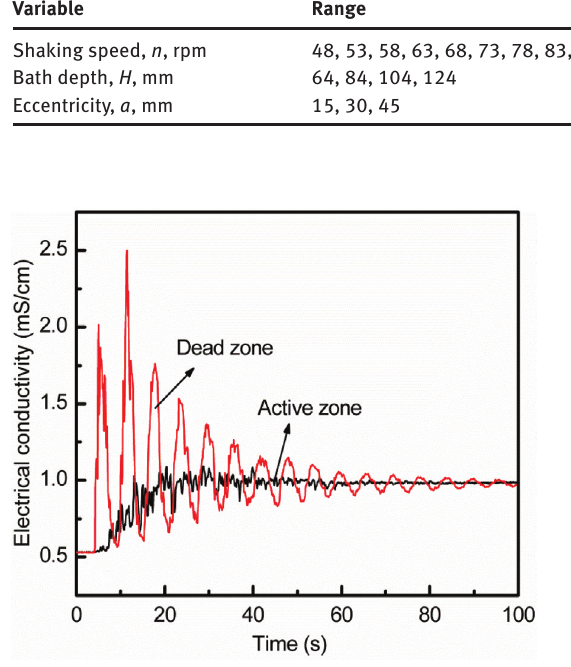
Fig. 3: Typical curves of electrical conductivity vs . time